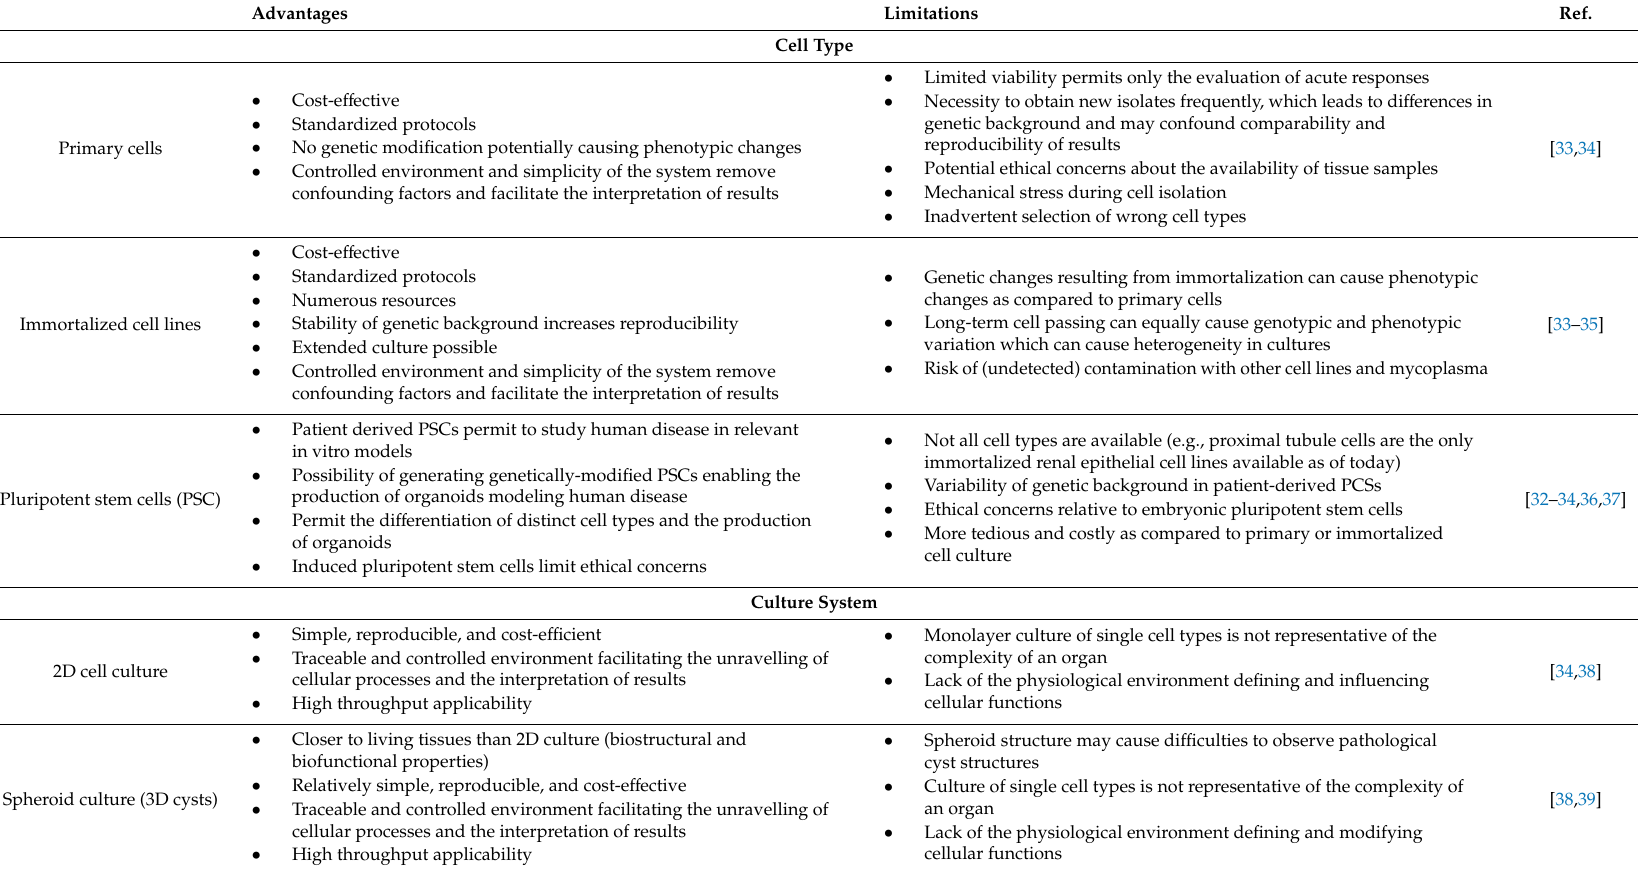
Table 1. Broad overview of the advantages and limitations of the di ff erent in vitro models used in ADPKD